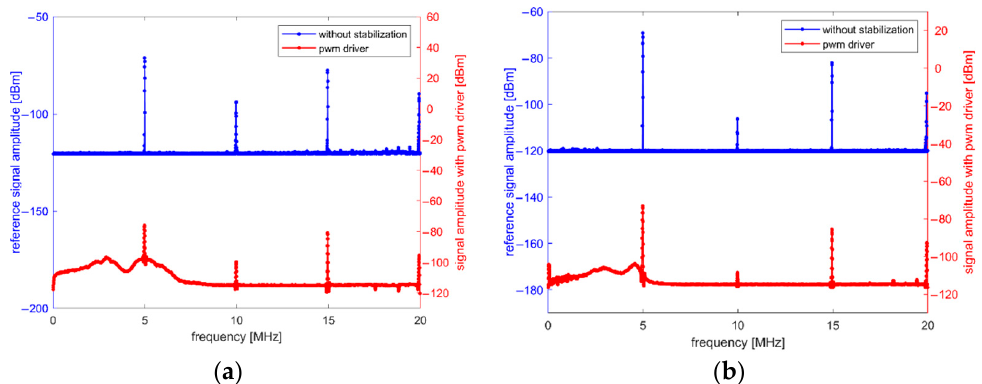
Figure 10. Frequency spectrums of reference QCM signal and QCM signal with PWM driver enabled ( a ) electric field; ( b ) magnetic field.